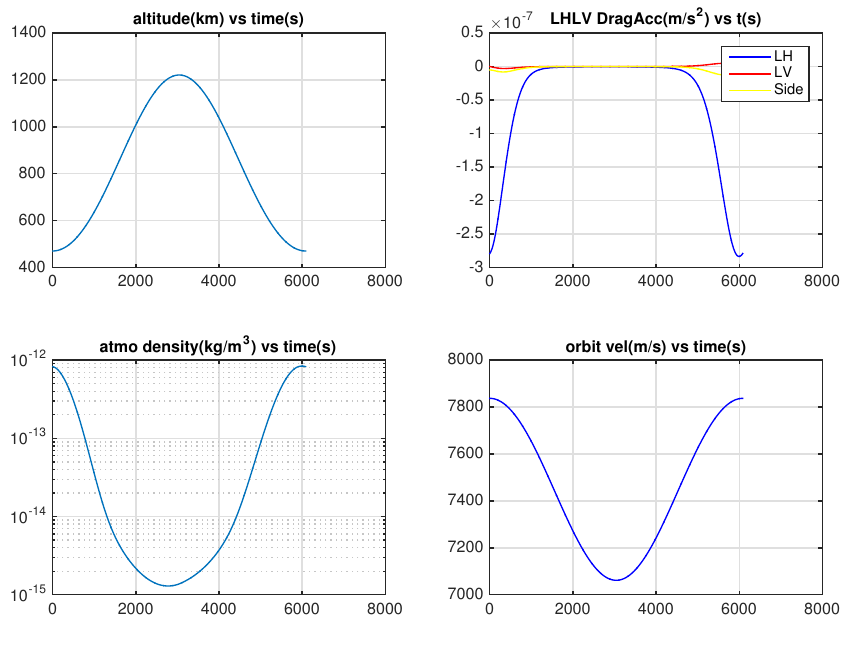
Figure 3. Altitude profile ( upper left ); atmospheric density ( lower left ); drag acceleration components ( upper right ); and orbital velocity ( lower right ). All quantities are plotted over one